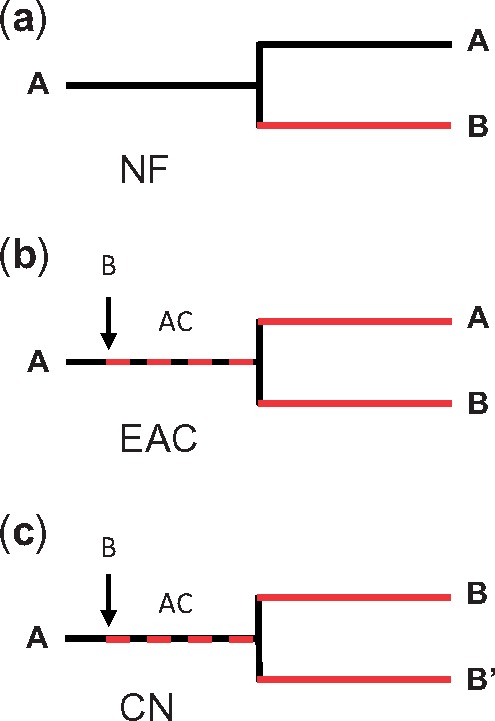
Retention and divergence of duplicate genes under positive selection. Red lines indicate positive, black lines purifying, and dashed red/black lines balancing selection. (a) NF. After gene duplication, one copy acquires a novel, adaptive function (B), whereas the other copy retains the ancestral function (A). (b) EAC. A novel function (B) emerges before gene duplication, leading to an adaptive conflict (AC) between ancestral function (A) and novel function (B). Gene duplication resolves this conflict. One copy improves the ancestral (A), the other the novel function (B). (c) CN. A novel function (B) emerges before gene duplication, leading to an adaptive conflict (AC) between ancestral function (A) and novel function (B). Dosage effects favor duplication and environmental change renders the ancestral function (A) obsolete. Both gene copies are selected for novel functions (B, B′).